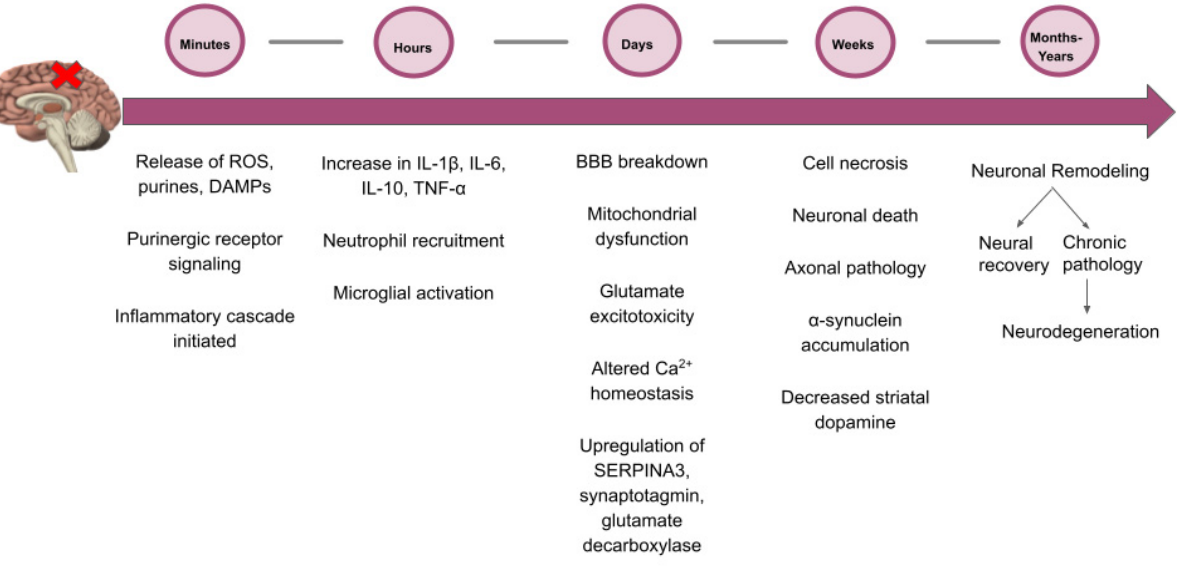
Figure 1. The timeline of inflammatory, immunological, cellular, and neural events occurs minutes to years following TBI.